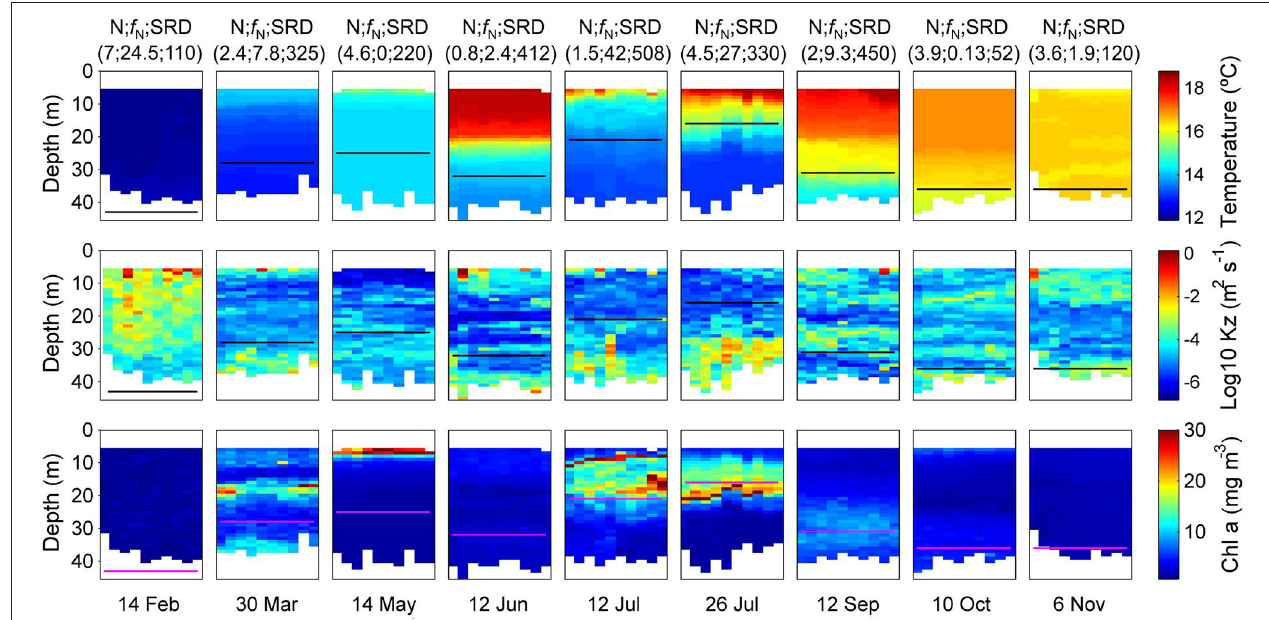
FIGURE 1 | Vertical distribution of temperature, vertical diffusivity or mixing ( Kz , note the logarithmic scale), and chlorophyll- a concentration estimated from the microturbulence profiler deployed from February to November 2012 at the central station at the Ría de Vigo. The 10 microturbulence profiles deployed at each sampling are plotted. The black/magenta line represents the euphotic layer depth computed as the depth where the photosynthetic available radiation (PAR) is 1% of its surface value. Top labels indicate the concentration of inorganic nitrogen (nitrate plus ammonium) in the surface waters (mmol N m − 3 ), the nitrate flux into the euphotic zone (mmol N m − 2 d − 1 ), and the solar radiation dose (Watts m − 2 ). Bottom labels indicate sampling dates.